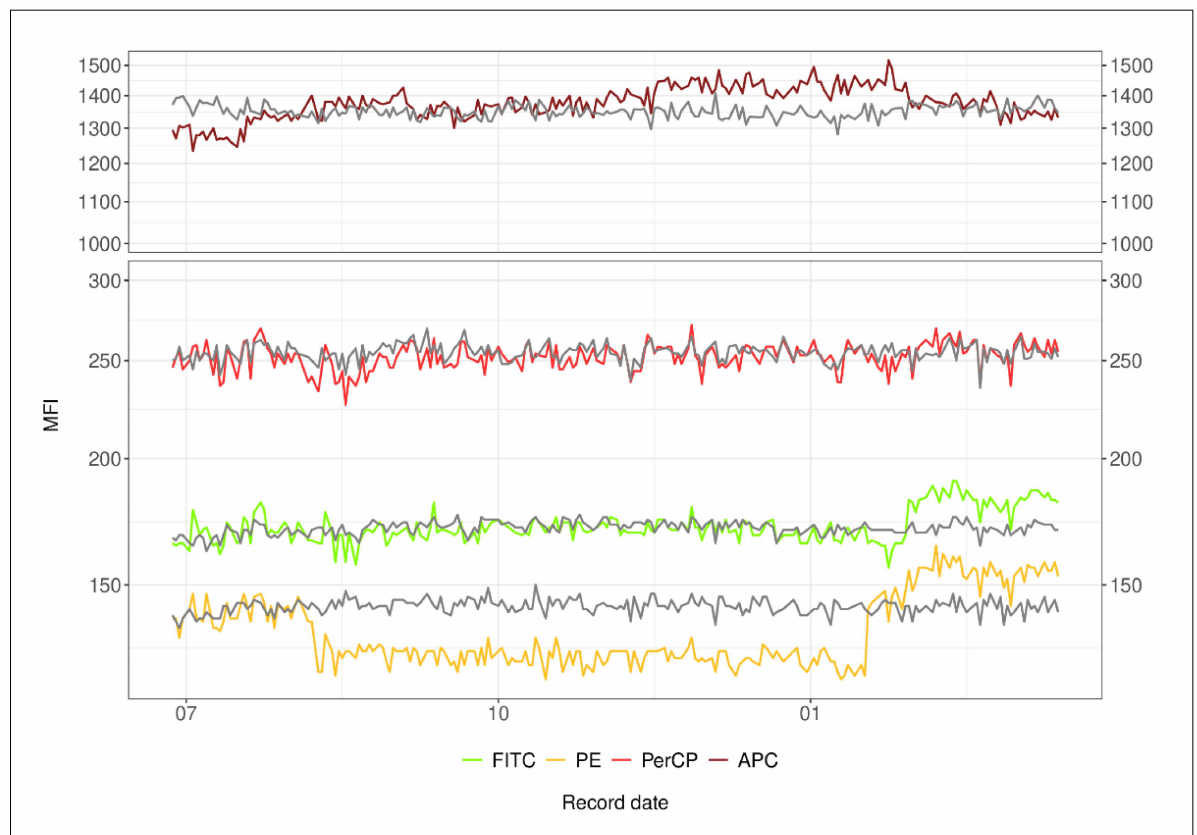
Figure 3. Measured (colored) and normalized (grey) MFIs of peak 2 of the Rainbow beads for instrument CantoIIA during an 8-month time period (July 2018 to April